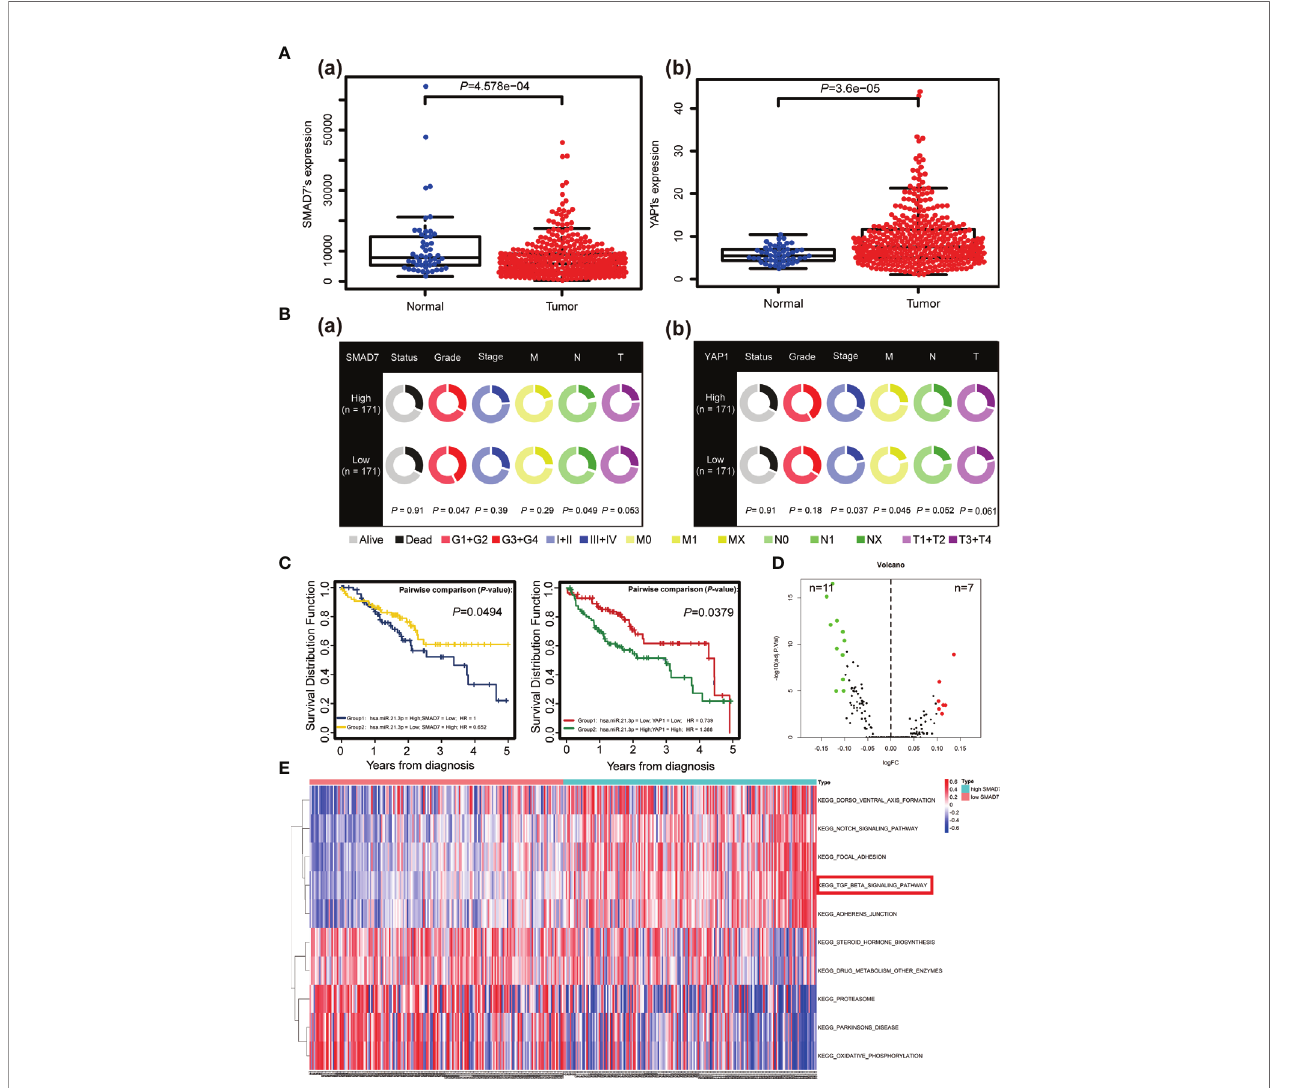
FIGURE 6 | The clinical signi fi cance of SMAD7/YAP1 in HCC based on bioinformatics analysis. (A) Discrepancies in SMAD7 (a) and YAP1 (b) expression levels in liver tumor tissues (Tumor) and non-paired relative normal samples (Normal) from the TCGA database are presented. (B) Relationship between expression of SMAD7 (a), YAP1 (b) and HCC clinicopathological terms as quanti fi ed using the Wilcoxon rank-sum test. Data with incomplete clinical traits were excluded from analysis. (C) Kaplan-Meier curves representing overall survival (OS, as percentage) in HCC patients based on miR-21-3p/SMAD7 or miR-21-3p/YAP1 levels from the studied TCGA data set (n = 376). Statistical signi fi cance among miRNA/mRNA expression and OS was determined using the log-rank test. SMAD7-related KEGG pathways based on gene set variation analysis of TCGA data are shown in volcano (D) and heat (E) maps (top ten including representative terms),